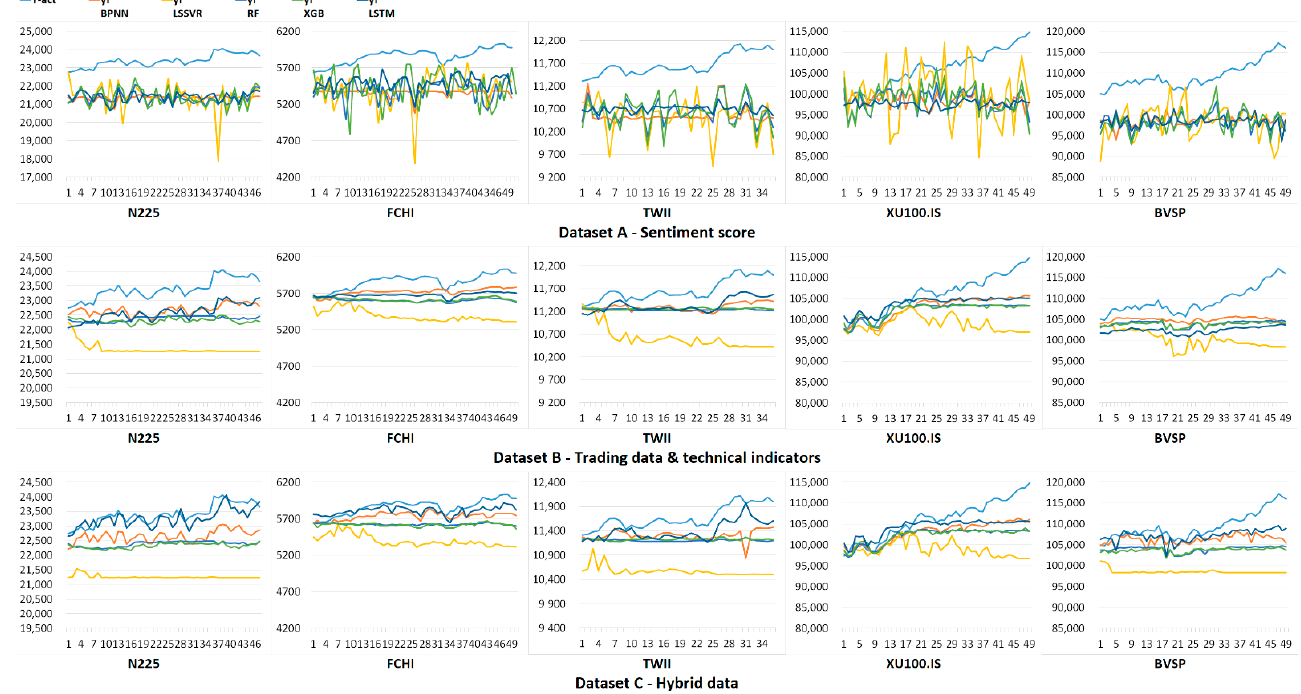
Figure 10. Point-to-point plots of actual values and predicted values of stock market indices.